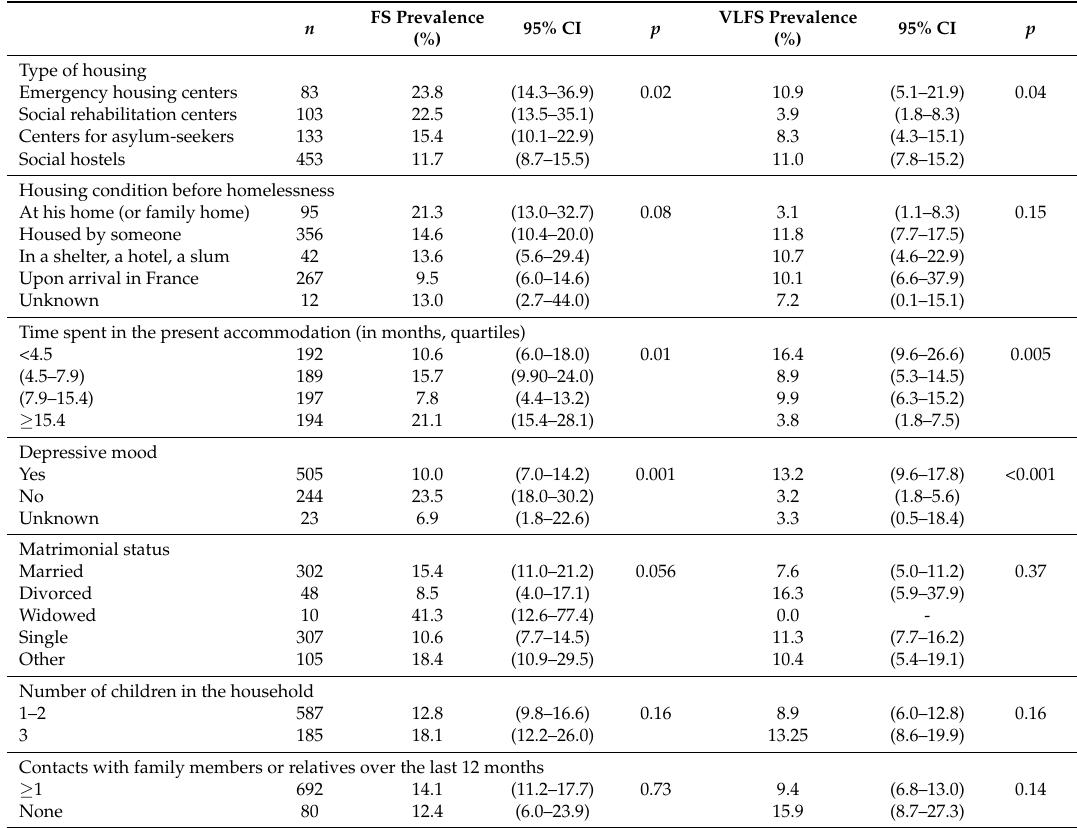
Table 2. Prevalence of food security (FS) and very low food security (VLFS) in different subgroups of homeless